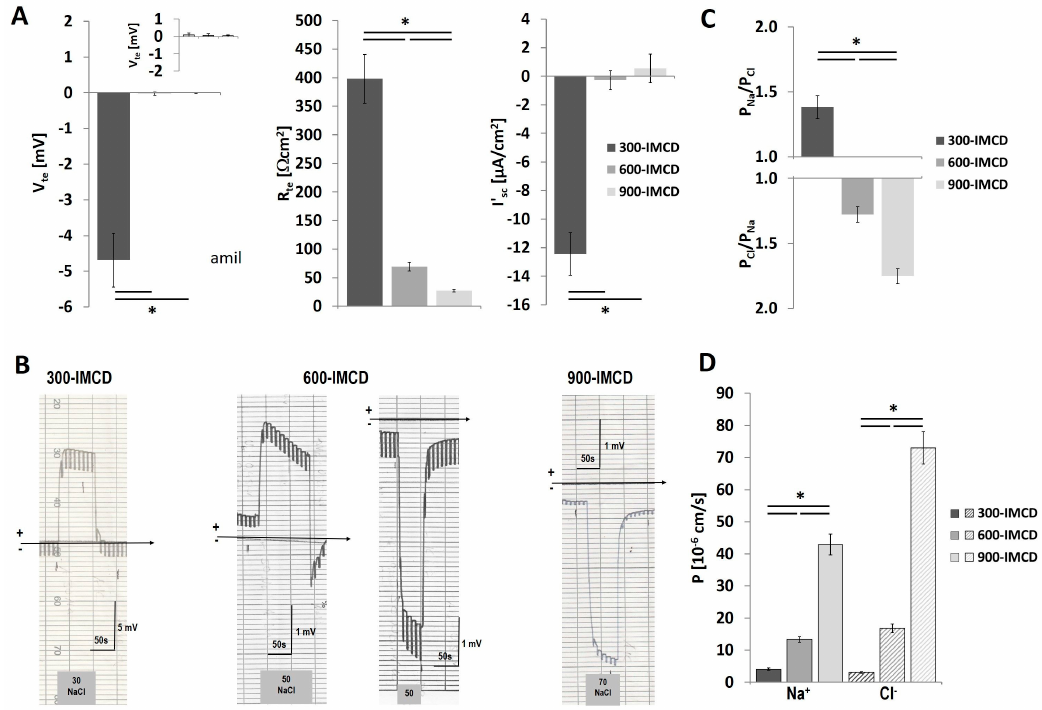
Figure 6. Comparison between 300-IMCD, 600-IMCD, and 900-IMCD after five days of cultivation. ( A ) Electrophysiological properties with transepithelial voltage V te , transepithelial resistance R te and equivalent short-circuit current I’ sc . Insert in Vte panel: Vte in the presence of 50 µ M amiloride. ( B ) Original experiments showing 30 mmol / L NaCl (300-IMCD), 50 mmol / L (600-IMCD), and 70 mmol / L (900-IMCD) di ff usion potentials. ( C ) Summarized permeability ratio PNa / PCl and PCl / PNa, respectively. ( D ) Calculated Na + and Cl - permeabilities. Data are means ± SEM, n = 24, 39, 46; * p < 0.05.